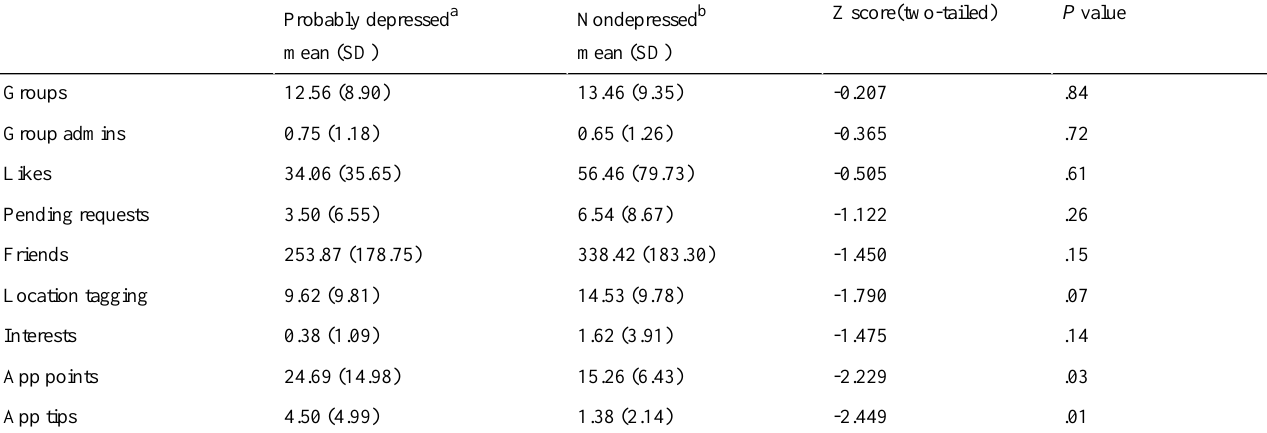
Table 4. Results of the Mann-Whitney U test of Facebook social features between those who were probably depressed a (n=16) and nondepressed b (n=26).